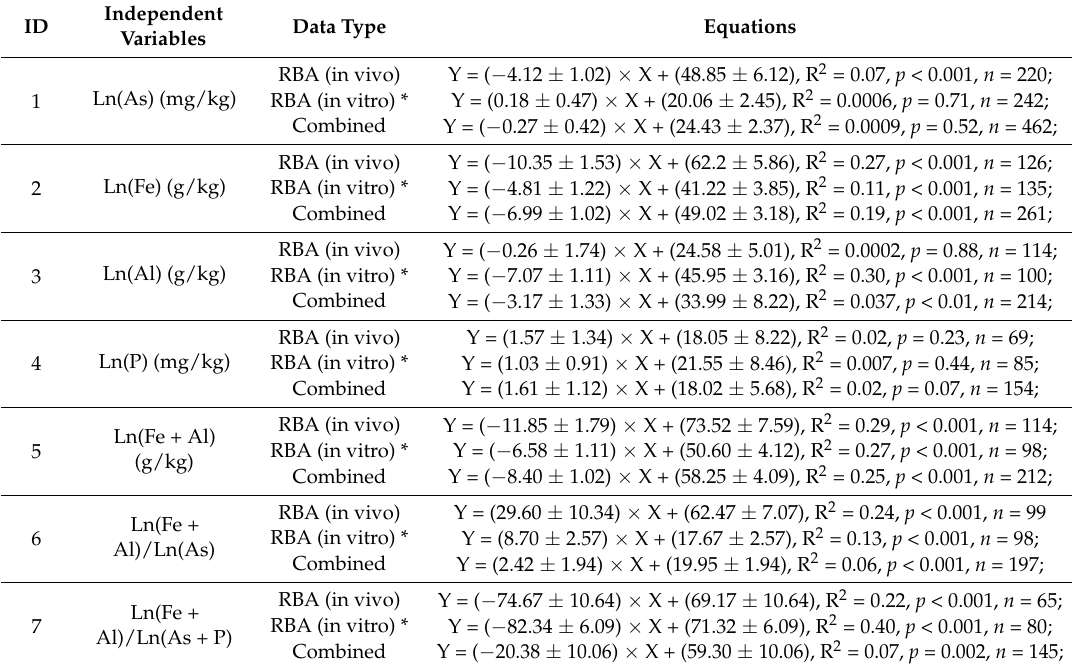
Table 3. Regressions for relation between selected metals and arsenic